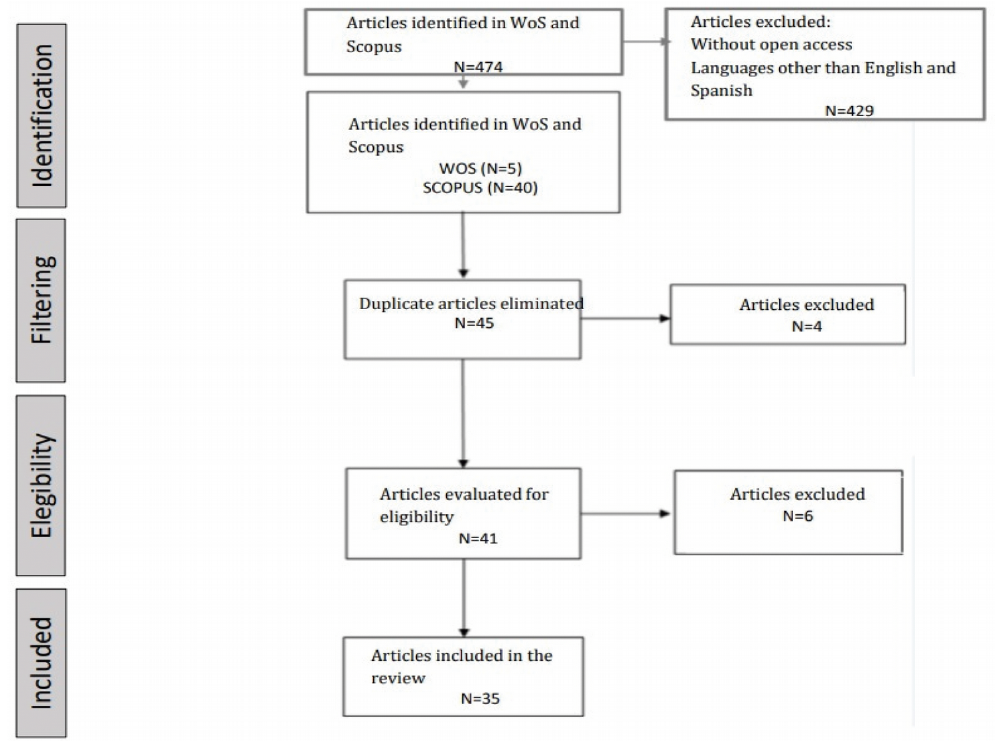
Figure 1. Prisma diagram for the Scoping